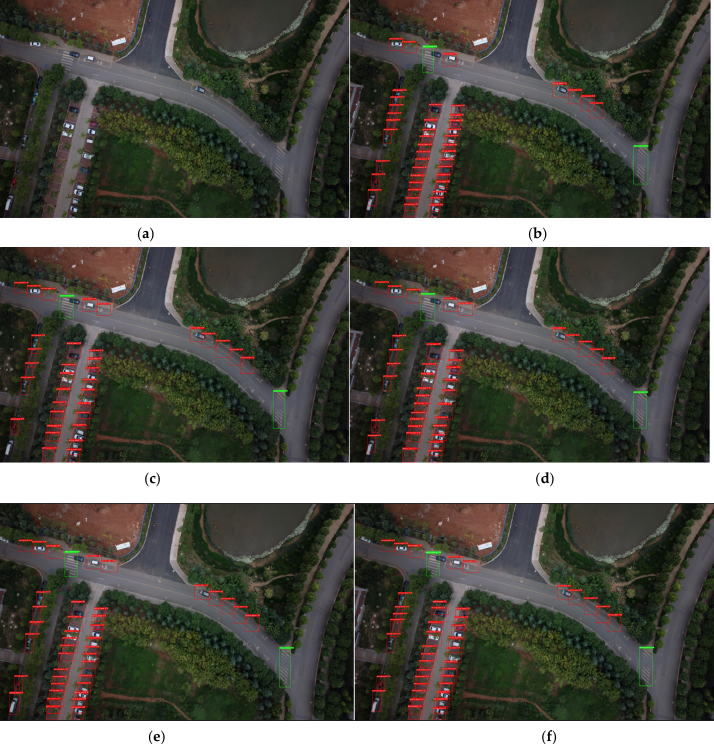
Figure 11. Effect of detection with occlusion in small target scenes: ( a ) detection of the original image; ( b ) YOLOv5; ( c ) YOLOv5 with SPPF; ( d ) YOLOv5 with K-means++; ( e ) YOLOv5 with ASFF; and ( f ) ASFF-YOLOv5.